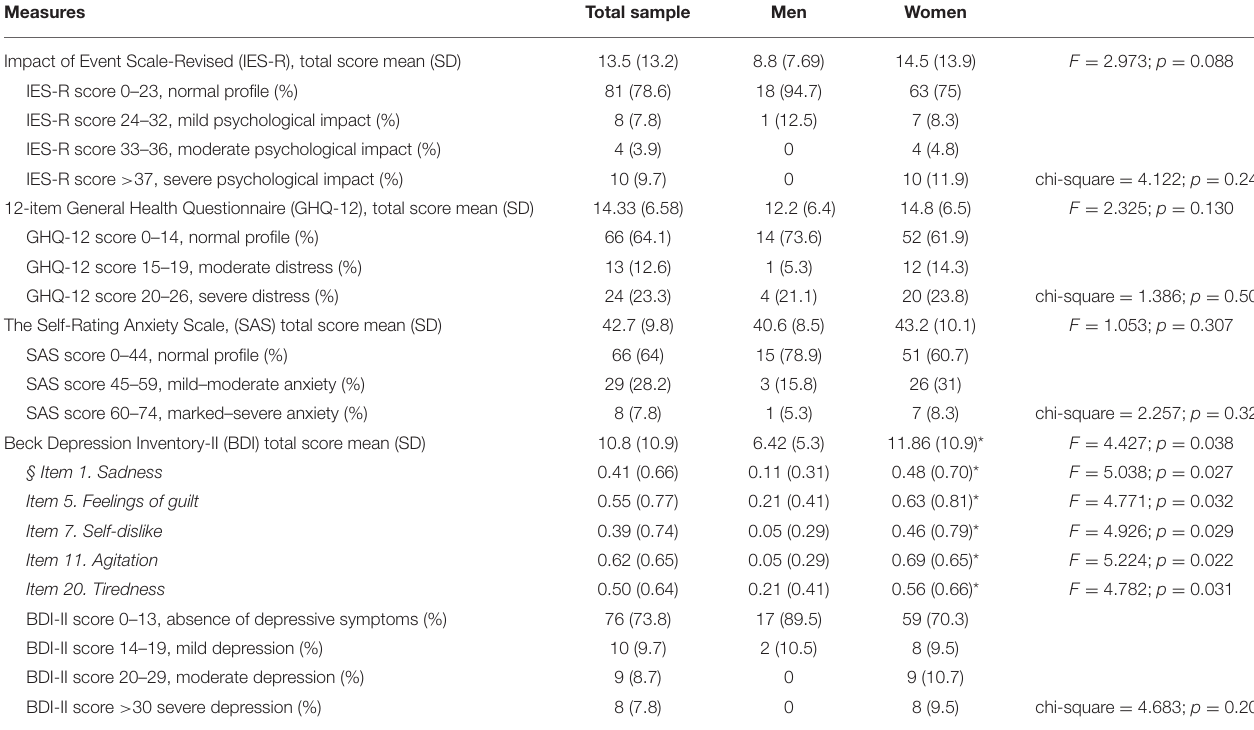
TABLE 2 | Statistics of traumatic, anxiety, and depressive symptomatology measures, assessed through the Impact of Event Scale-Revised 22 items (IES-R2), 12-item general health questionnaire (GHQ-12), self-rating anxiety scale (SAS), and beck depression inventory-II (BDI-II). Measures Total sample Men Women Impact of Event Scale-Revised (IES-R), total score mean